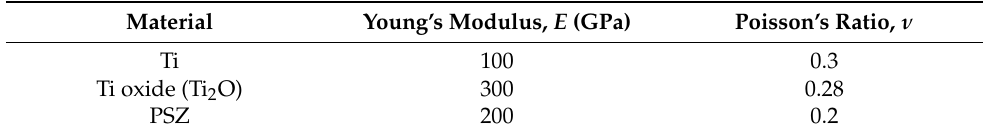
Figure 5. Finite element meshes and boundary conditions of the model for evaluating the accuracy of DIM. Table 1. Elastic properties of Ti, Ti oxide, and PSZ used in this section.